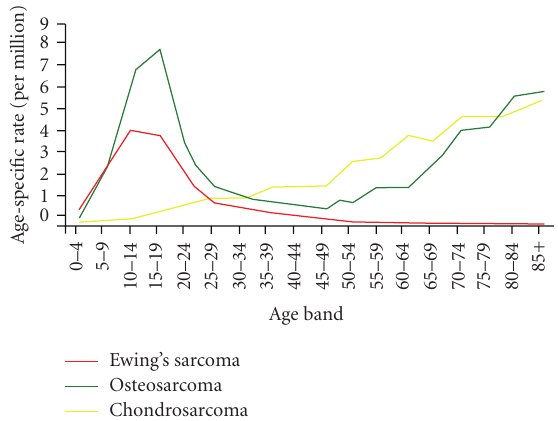
Figure 1: Age-specific incidence rates by morphology, England,